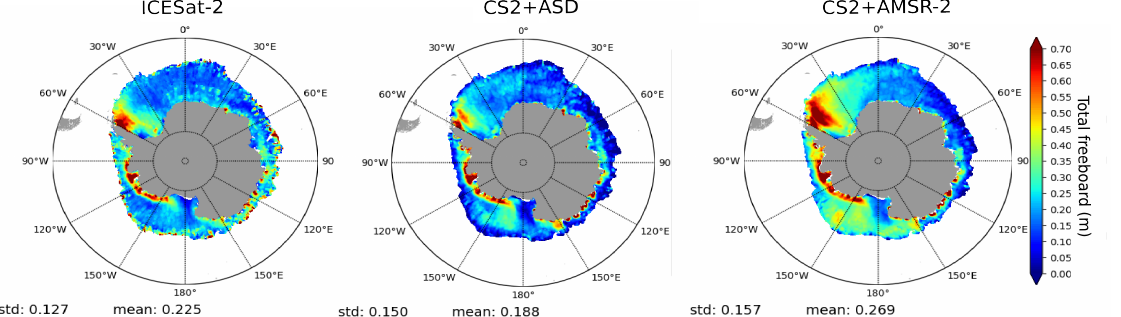
Figure 7. Maps of the annual mean total freeboards of ICESat-2, compared with CryoSat-2 estimations computed using ASD and AMSR-2 snow depth data in